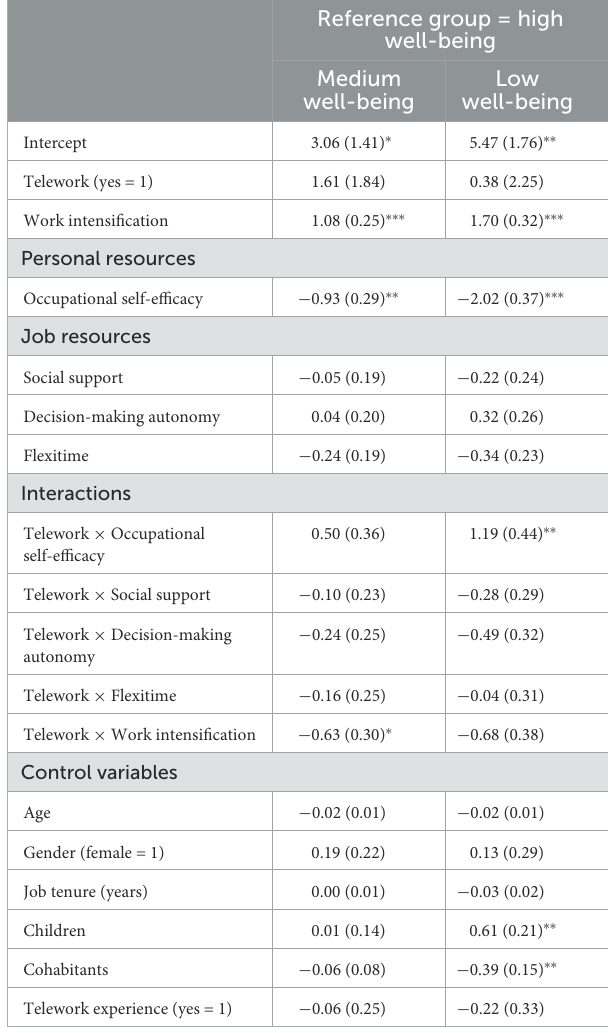
TABLE 4 Multinomial logistic regression of group membership at T1, reference group: high